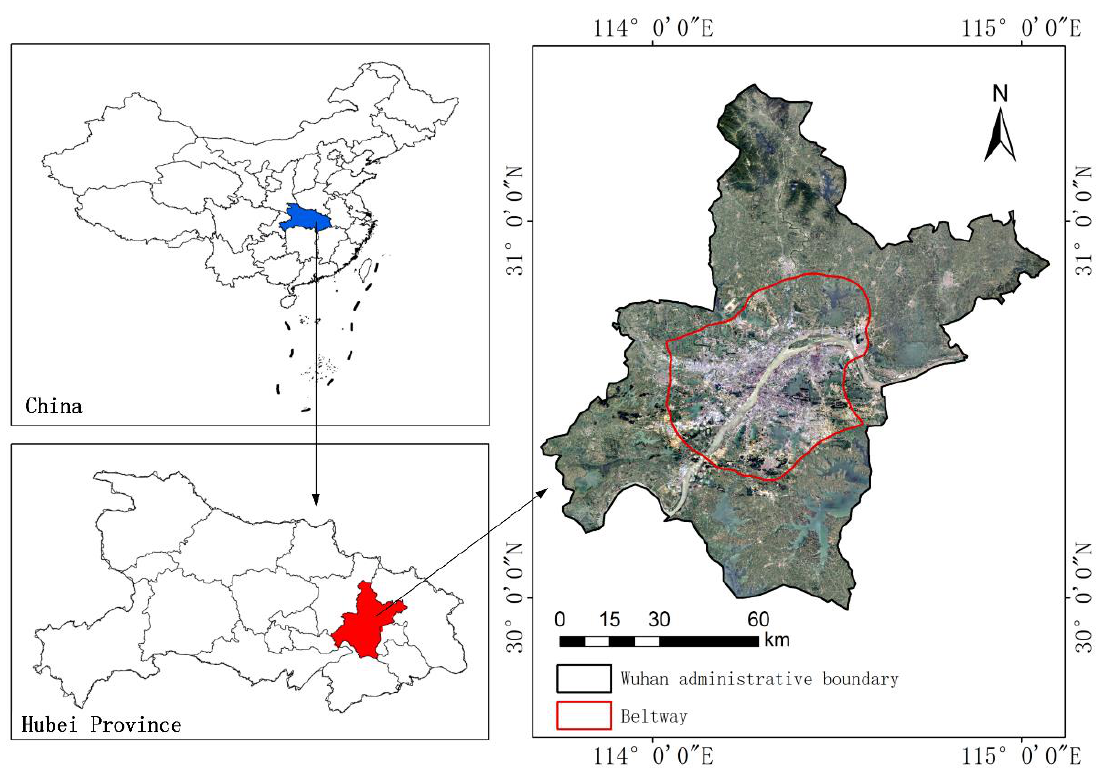
Figure 1. The location of Wuhan.